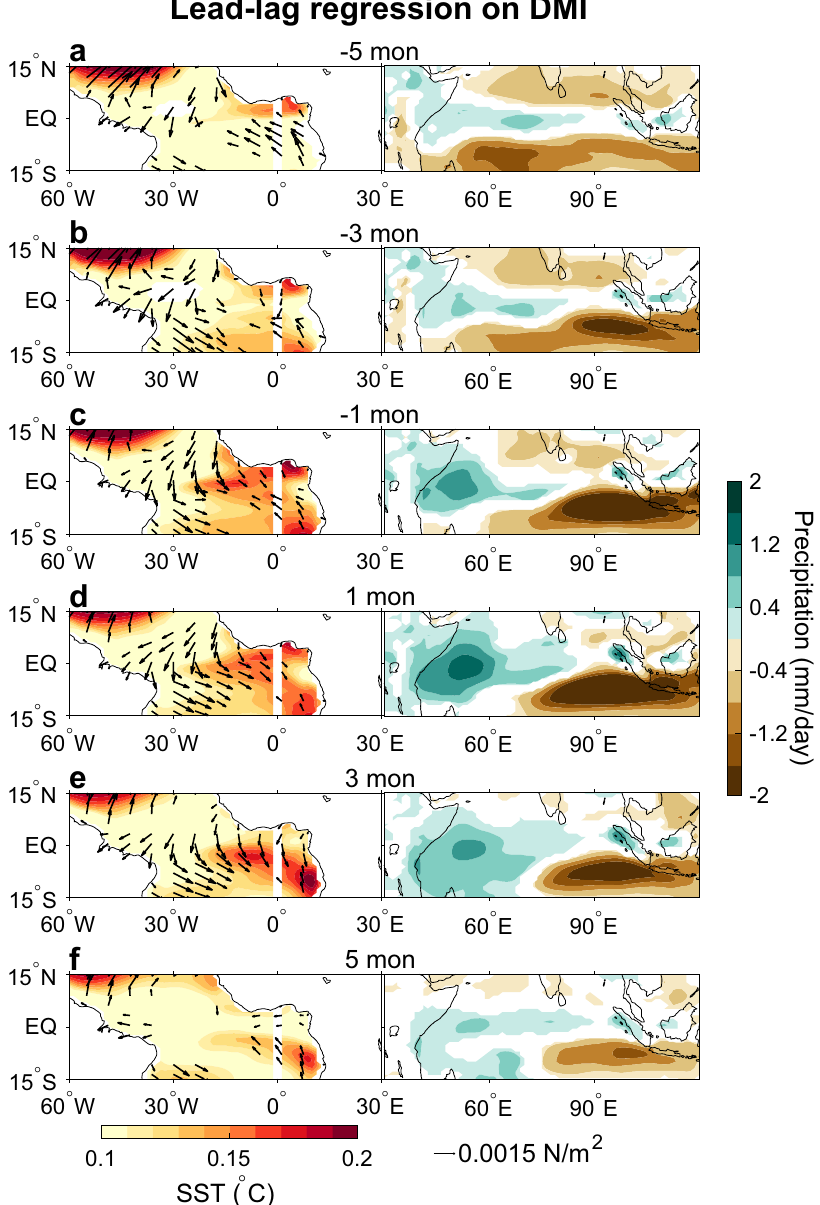
Fig. 5 Coupled climate model experiment assessing Indian Ocean sea surface temperature (SST) effect. Lead-lag regression of SST (shading; °C °C — 1 ) and surface wind stress (N m − 2 °C − 1 ) anomalies in the tropical Atlantic Ocean and precipitation anomalies (shading; mm day − 1 °C − 1 ) in the tropical Indian Ocean on monthly Dipole Mode Index (DMI). Shown are ensemble mean Indian Ocean Pacemaker experiment results that are statistically signi fi cant at the 90% con fi dence level. a – f Results for — 5 to 5 months leading time, with negative representing months prior to Indian Ocean Dipole (IOD) peak and positive for after IOD